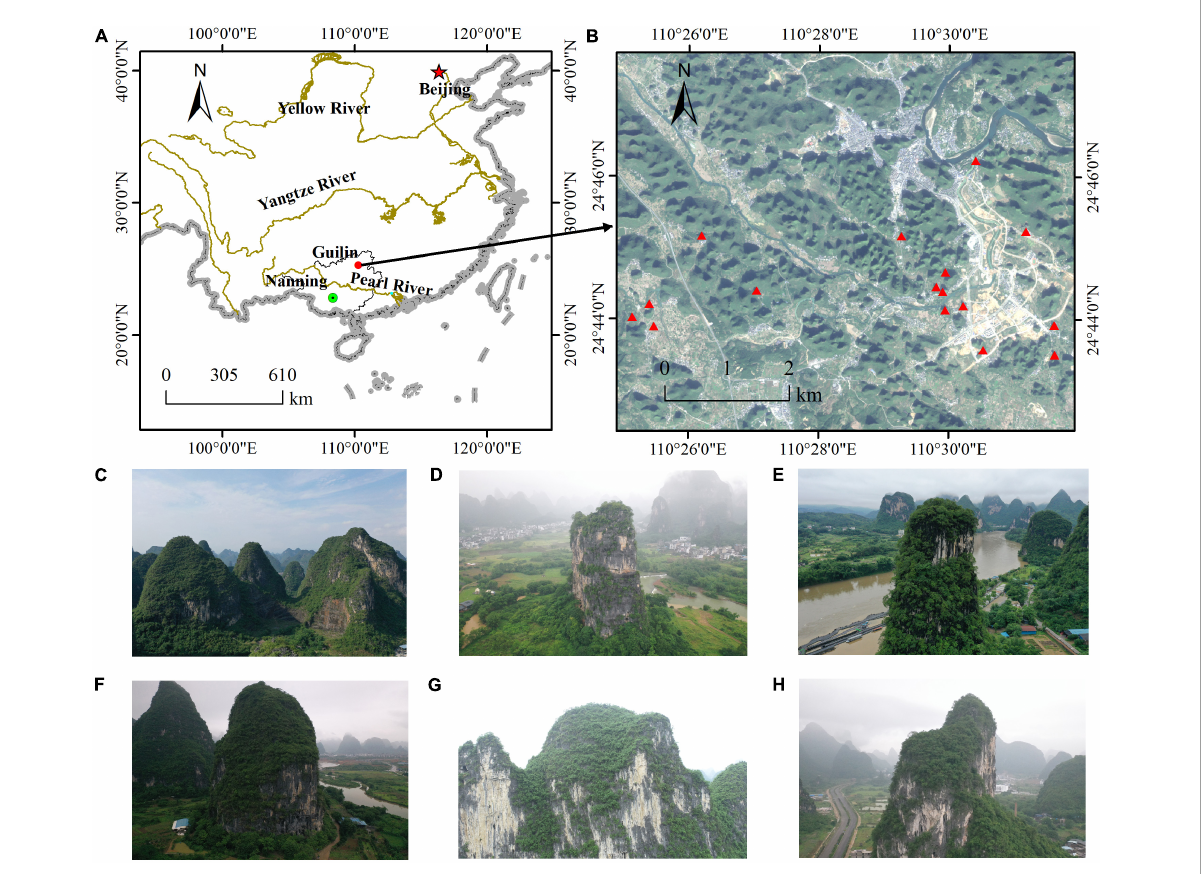
FIGURE2 (A) The study site at Guilin (China). (B) The 16 cliffs in the study area. (C–H) The different sizes of